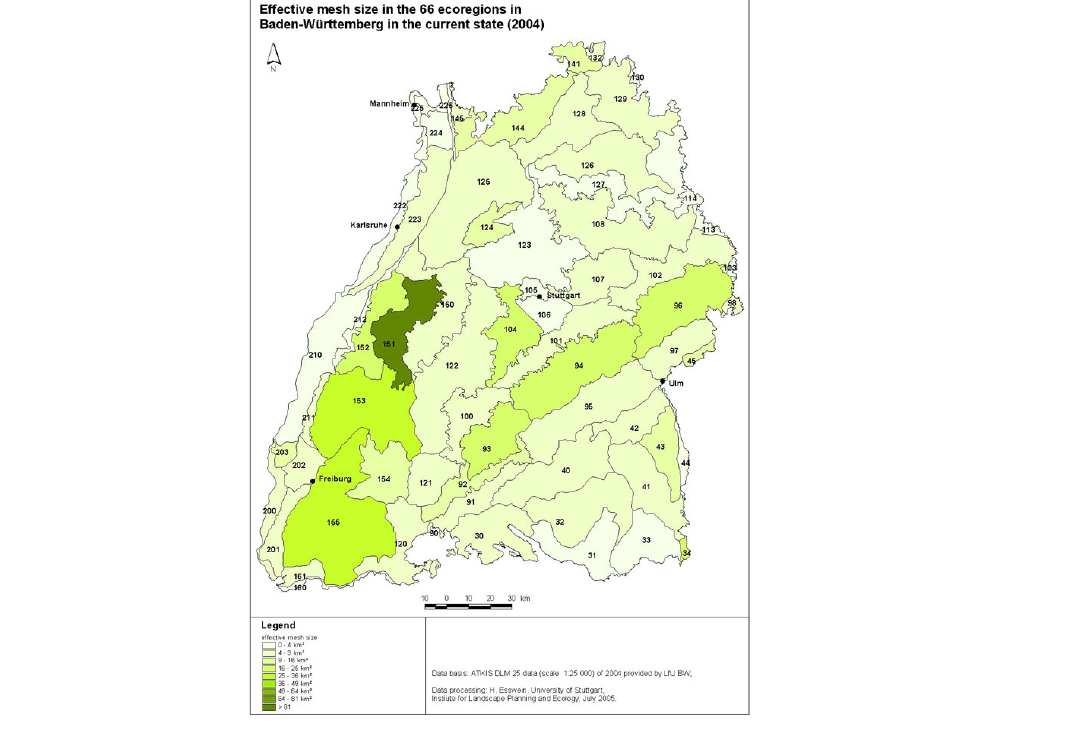
Fig. 6. The current (2004) degree of landscape fragmentation in the 66 ecoregions, or natural landscape units, in Baden-Württemberg (fragmentation level including municipal roads), in terms of the effective mesh size ( m ; in km²). The figures (identification numbers) identify the ecoregions (in alphabetical eff order): Adelegg (34), Albuch und Härtsfeld (96), Alb-Wutach-Gebiet (120), Baar (121), Baaralb und Oberes Donautal (92), Bauland (128), Bergstrasse (226), Bodenseebecken (31), Die Filder (106),